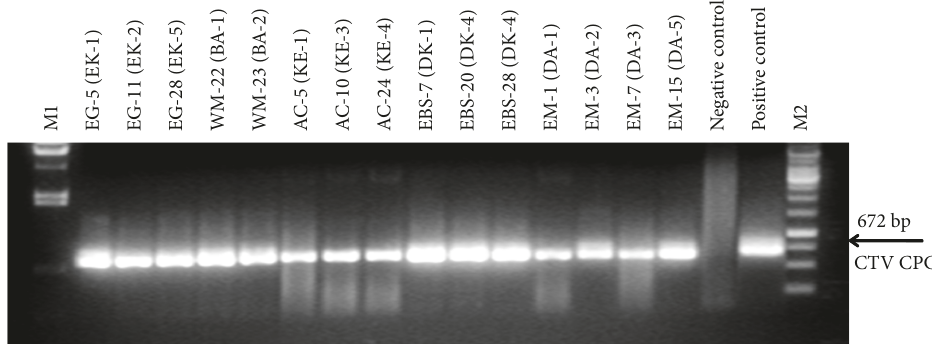
Figure 1: The amplification of 672 bp the CP gene from CTV isolates collected from different citrus growing regions of Turkey. Letters and numbers at the top indicate the names of the isolates. M1 is the Hind III digested lambda DNA and M2 is 1 kb DNA ladder. Healthy Madam Vinous sweet orange was used as negative control. Mexican lime infected with previously characterized CTV I˘gdır isolate was used as the positive